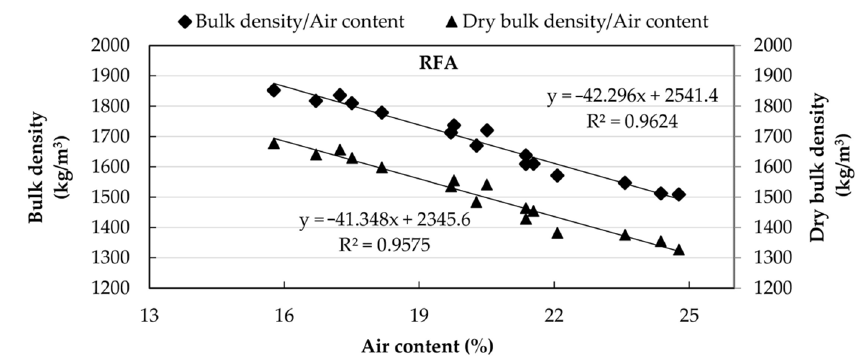
Figure 10. Correlation between densities (fresh and dry state) and the air content in mortar made with RFA.